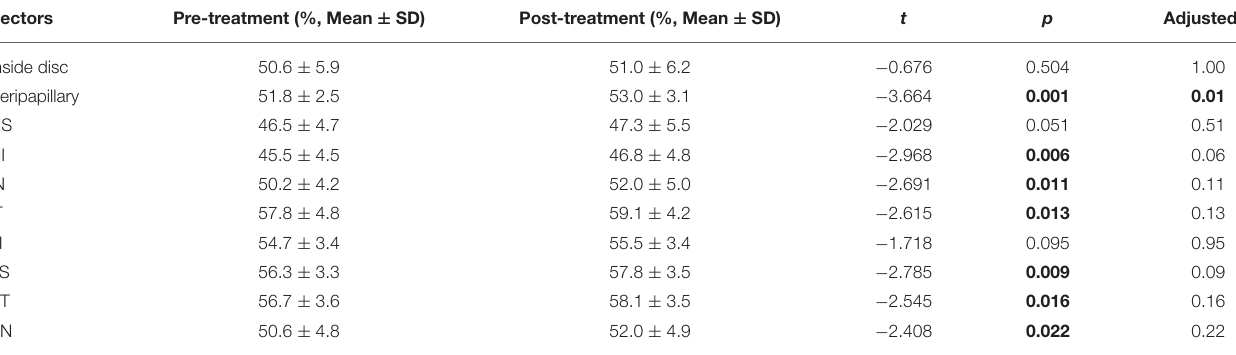
TABLE 2 | Peripapillary vessel density improved after IOP decrease ( N = 34).